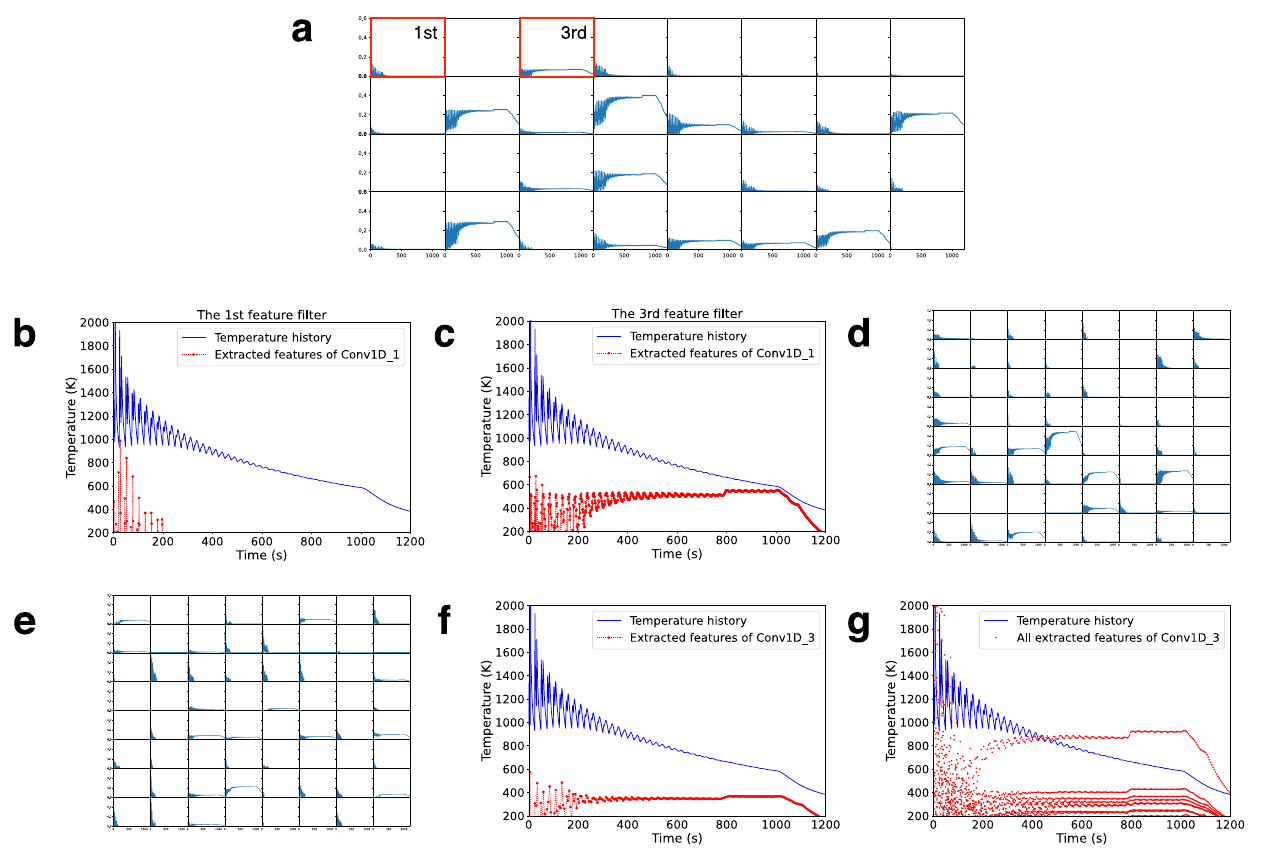
Fig. 9 The output of the fi rst, second, and third convolutional layer (Conv1D_1, Conv1D_2, Conv1D_3) for all channels. a Conv1D_1. d Conv1D_2. e Conv1D_3. Each subplot in a , d and e represents the output of the layer for a single one of the 32, 64 and 64 channels or fi lters. b , c Comparison of temperature history with extracted features from the Conv1D_1 with the fi rst and third feature fi lter. f , g Comparison of temperature history with extracted features from the Conv1D_3 for f a single feature fi lter and g all feature fi lters. The blue line represents temperature history of one case. The red dots are the extracted features from feature fi lters in the convolutional layer. The original extracted feature values are multiplied by 8000 for convenient comparison with temperature history in the same